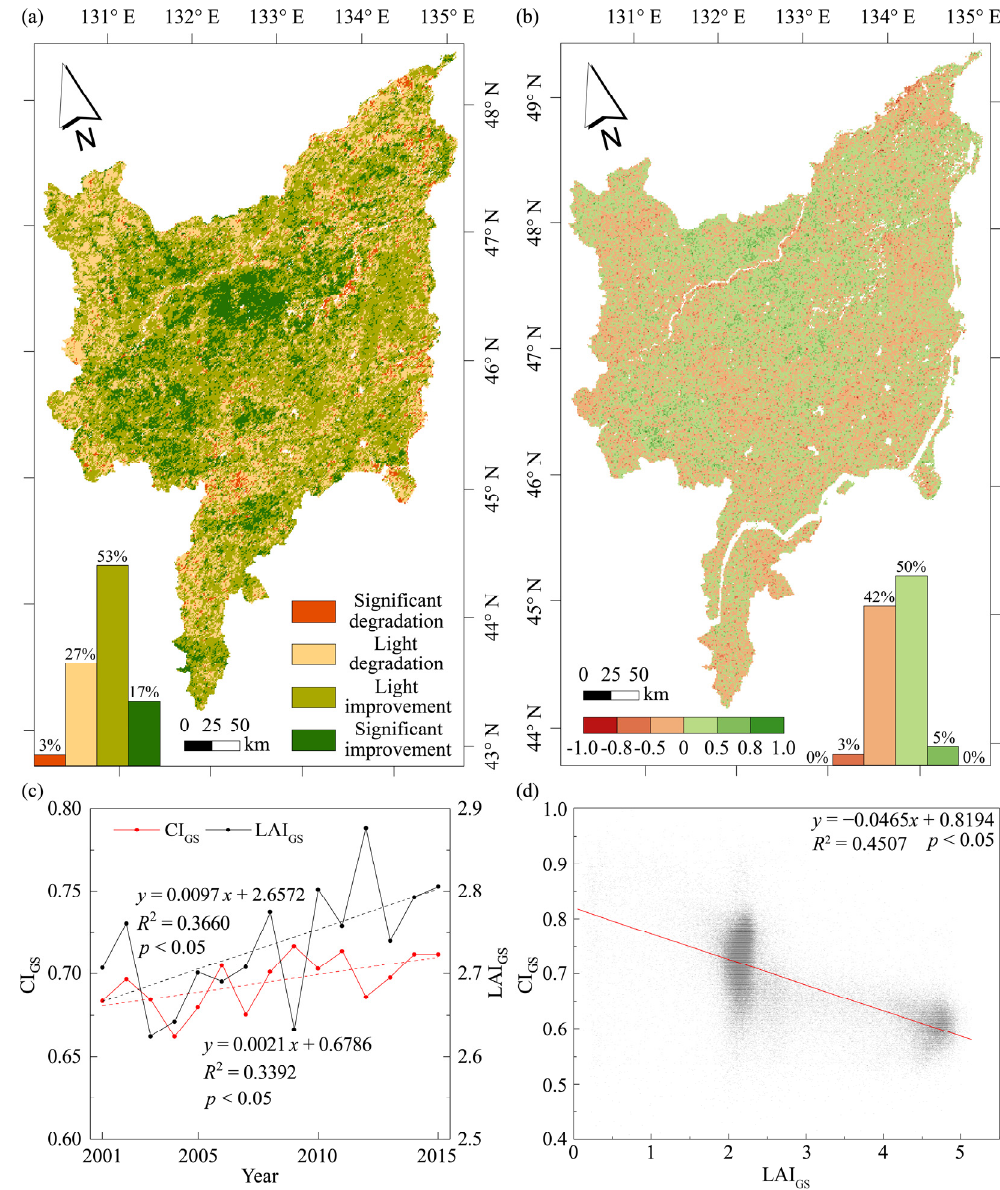
Figure 11. Correlation between CI and LAI: ( a ) spatial distribution of the variation trend of growing season mean LAI (LAI GS ); ( b ) spatial distribution of the correlation coefficient between CI GS and LAI GS ; ( c ) point plot of CI GS and LAI GS ; and ( d ) statistical analysis of multiyear mean CI GS and multiyear mean LAI GS .